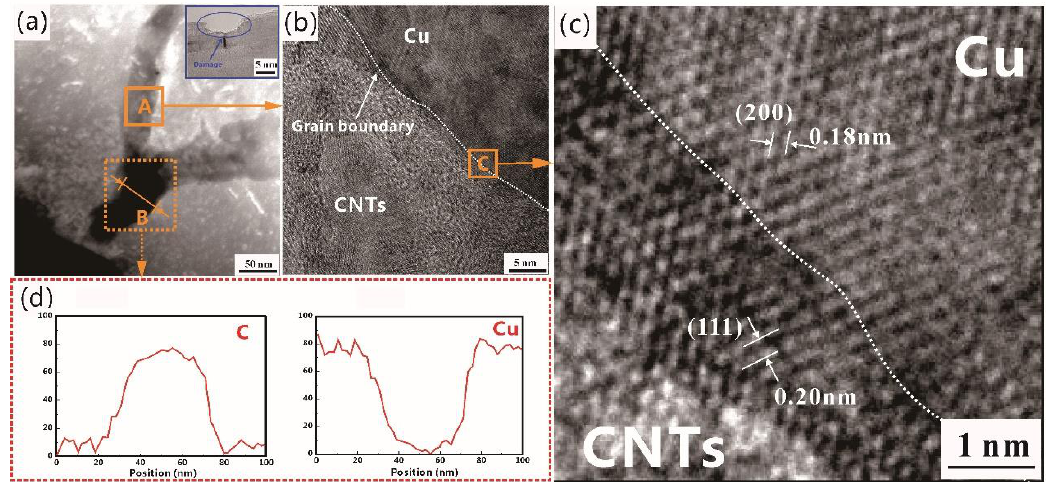
Figure 4. TEM images of Cu / CNT composite: ( a ) interface bonding of Cu and CNTs, ( b ) high-resolution TEM (HRTEM) image of highlighted region A, ( c ) HRTEM image of highlighted region C, and ( d ) energy-dispersive x-ray spectroscopy (EDS) line-scanning results of region B.